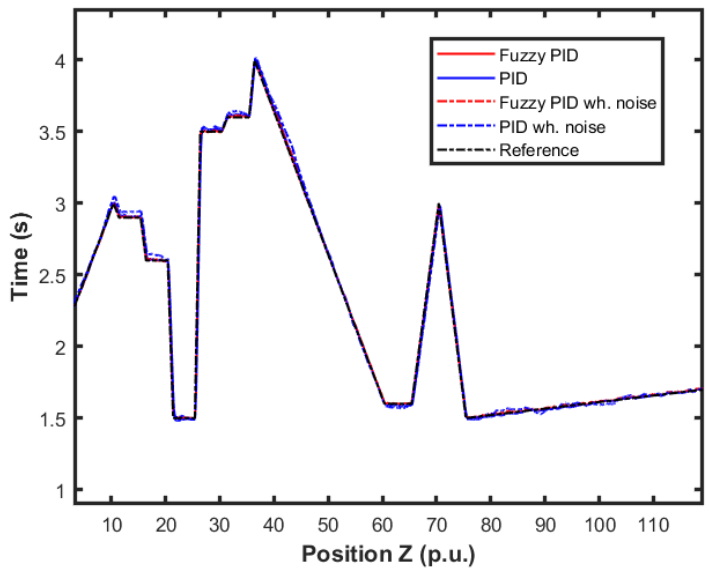
Figure 13. Comparison of the proposed method and PID controller for altitude control.